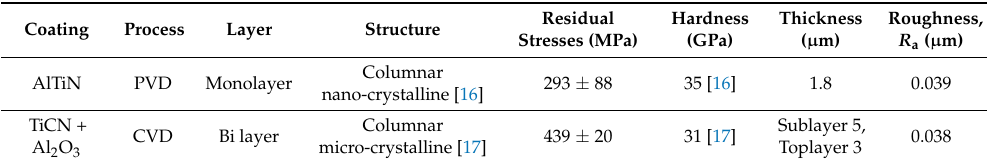
Table 2. Characteristics of coating